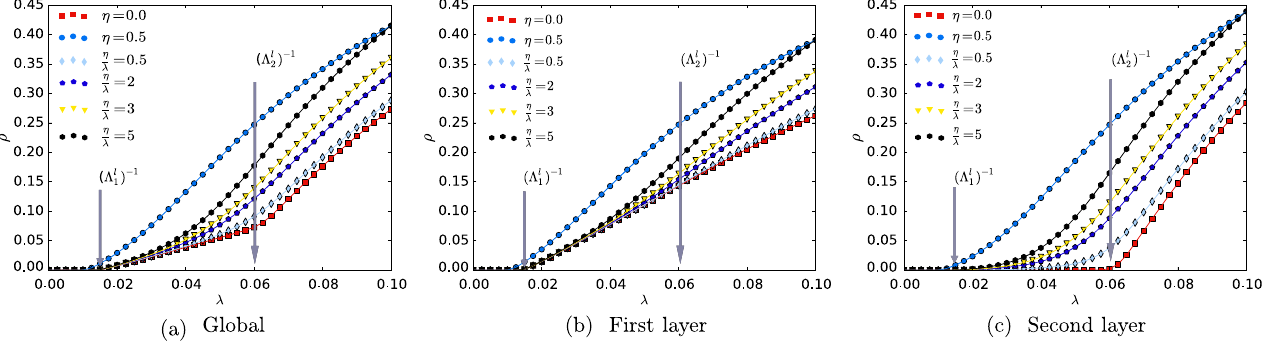
FIG. 3. Individual layer behavior over a two-layer multiplex system. Each layer has n ¼ 10 4 for a fixed value of μ ¼ 1 . The results considering both layers are shown in (a), while the dynamics in the individual layers are shown in (b) [ P ð k Þ ∼ k − 2 . 5 ] and (c) [ P ð k Þ ∼ k − 4 . 5 ]. The arrows indicate the leading eigenvalues of the